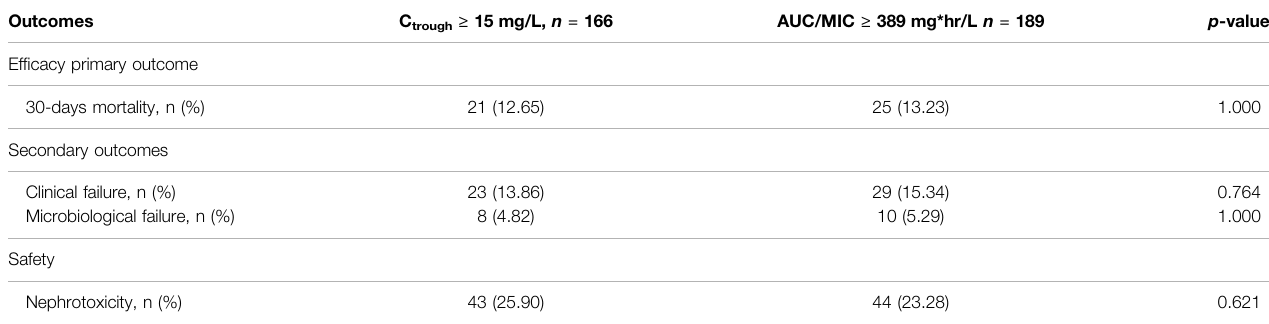
TABLE 6 | Analysis of ef fi cacy and safety of patients with vancomycin trough concentration ≥ 15 mg/L compared to AUC/MIC ≥ 389 mg*hr/L.